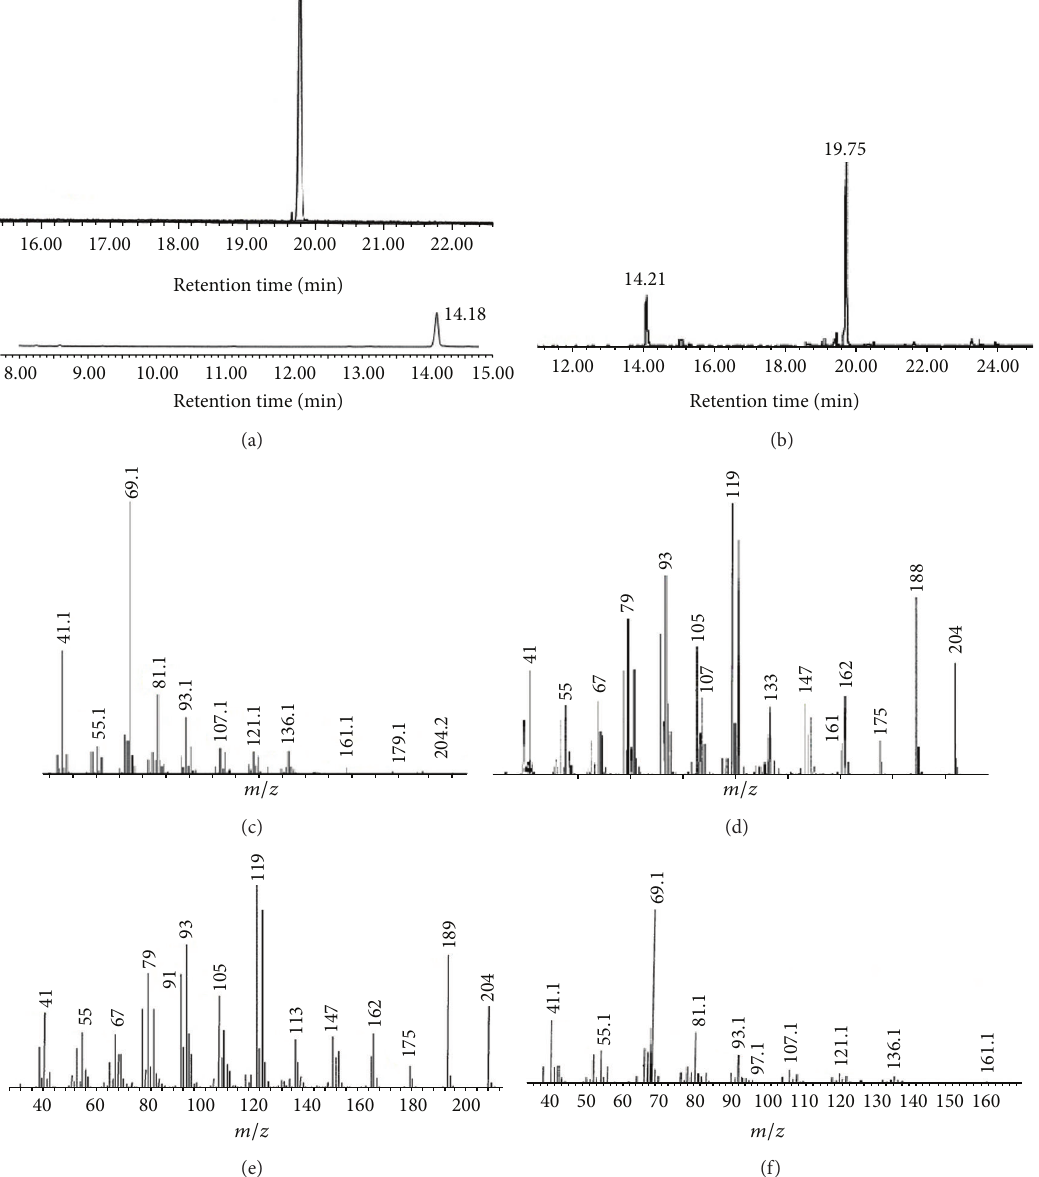
Figure 3: GC-MS profile of the amorphadiene and farnesol produced by YCF-005 strain. (a) Standard chromatogram of amorphadiene and farnesol, (b) ethyl extract sample chromatogram, (c) farnesol authentic standard mass spectrum, (d) amorphadiene authentic standard mass spectrum, (e) amorphadiene, and (f) farnesol sample mass spectrum generated from sample chromatogram